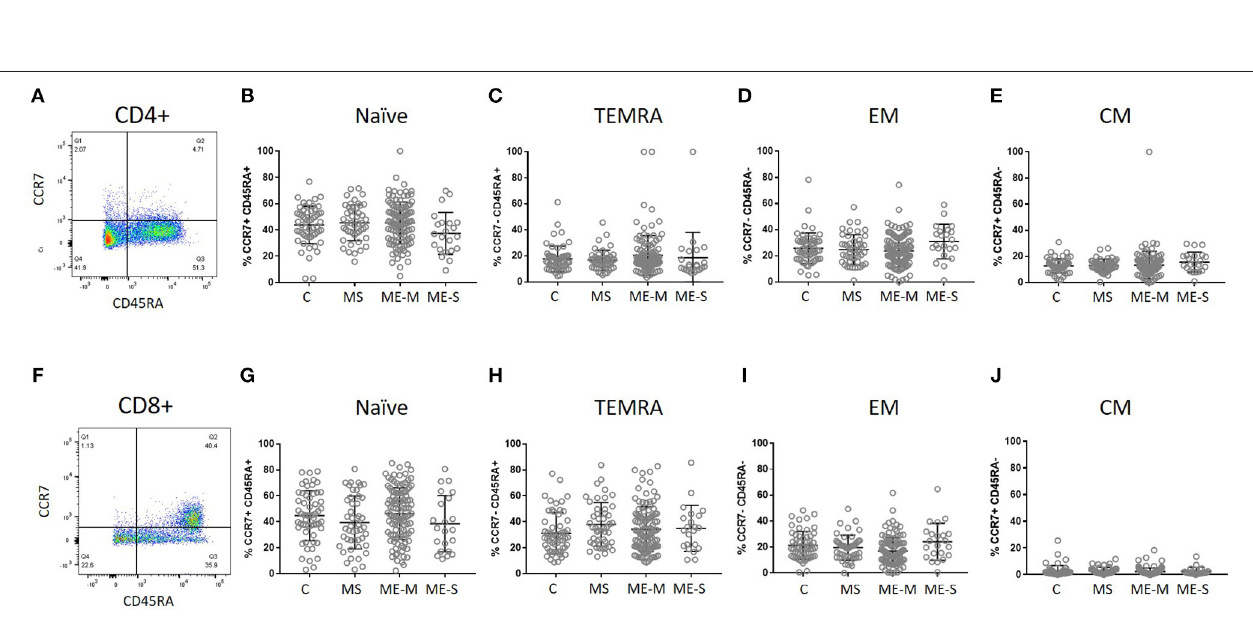
Frontiers in Immunology | www.frontiersin.org